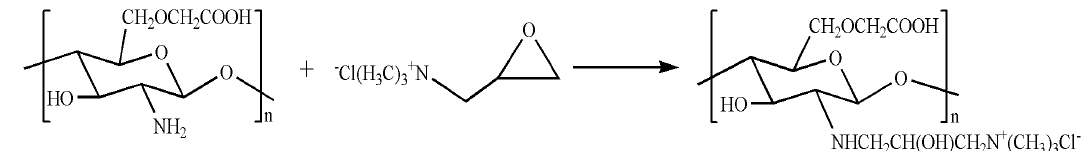
Figure 4. The reaction illustration of QCMC.